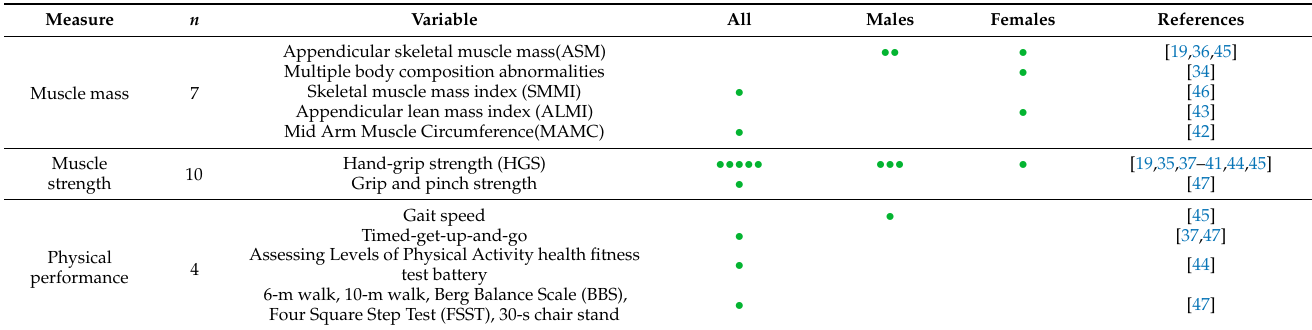
Table 3. Association between diet quality and selected sarcopenia measures ( n =